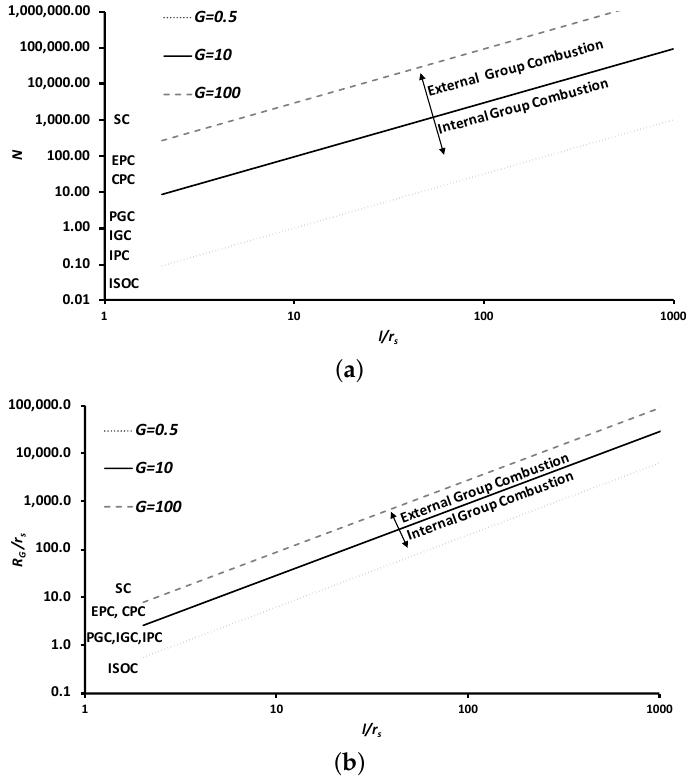
Figure 10. ( a ) The variation of the overall number of particles ( N ) with normalized interparticle dis- tance ( l / r s ) for various group combustion numbers ( G ) corresponding to different group combustion modes. ( b ) The variation of non-dimensional group radius ( R G / r s ) with normalized interparti- cle distance ( l / r s ) for various group combustion numbers ( G ) corresponding to different group combustion